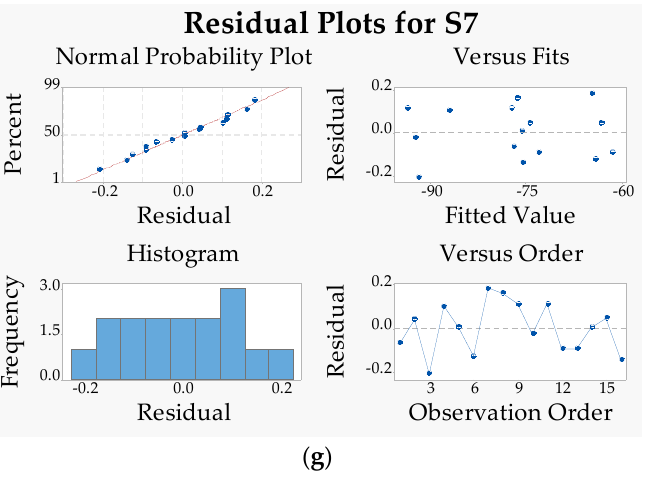
Figure 7. Residual plots: ( a ) S1 response; ( b ) S2 response; ( c ) S3 responses; ( d ) S4 response; ( e ) S5 response; ( f ) S6 response; ( g ) S7 response.